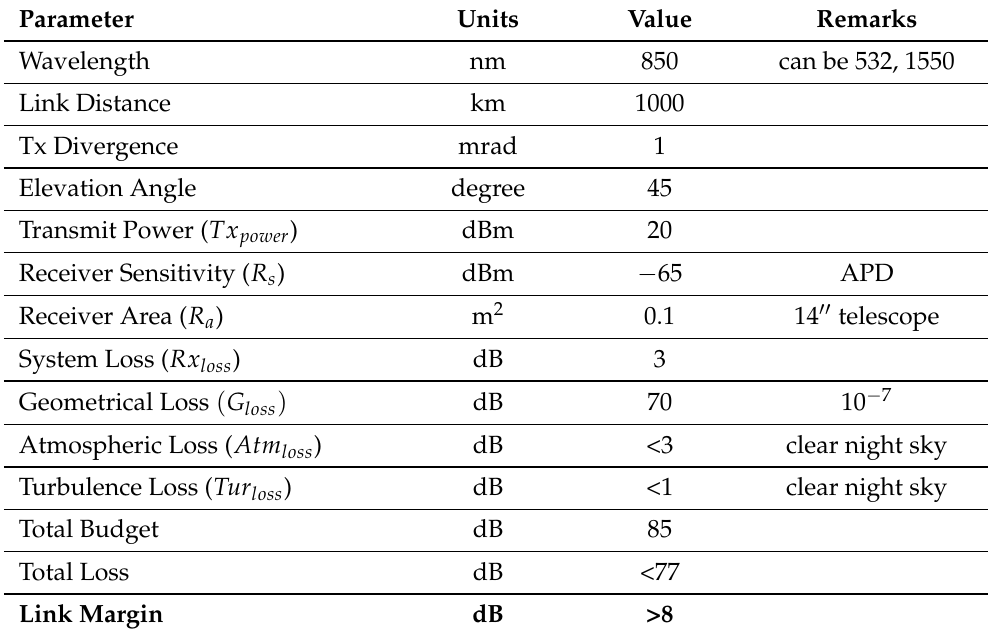
Table 2. Link-budget